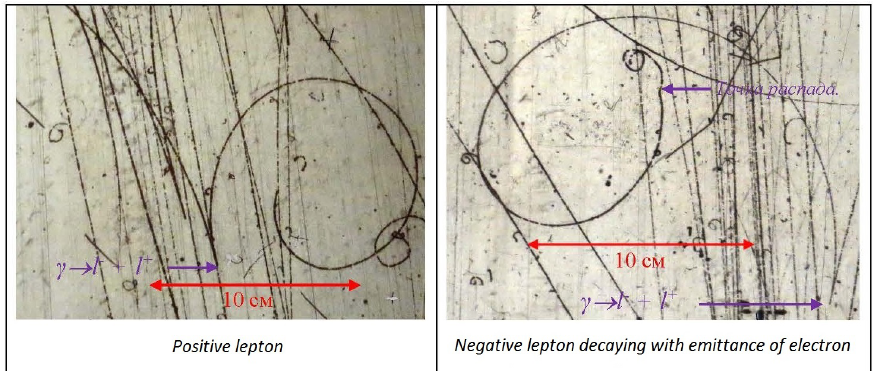
Figure 1. Examples of tracks of «anomalous leptons» found in the propane bubble chamber [1]